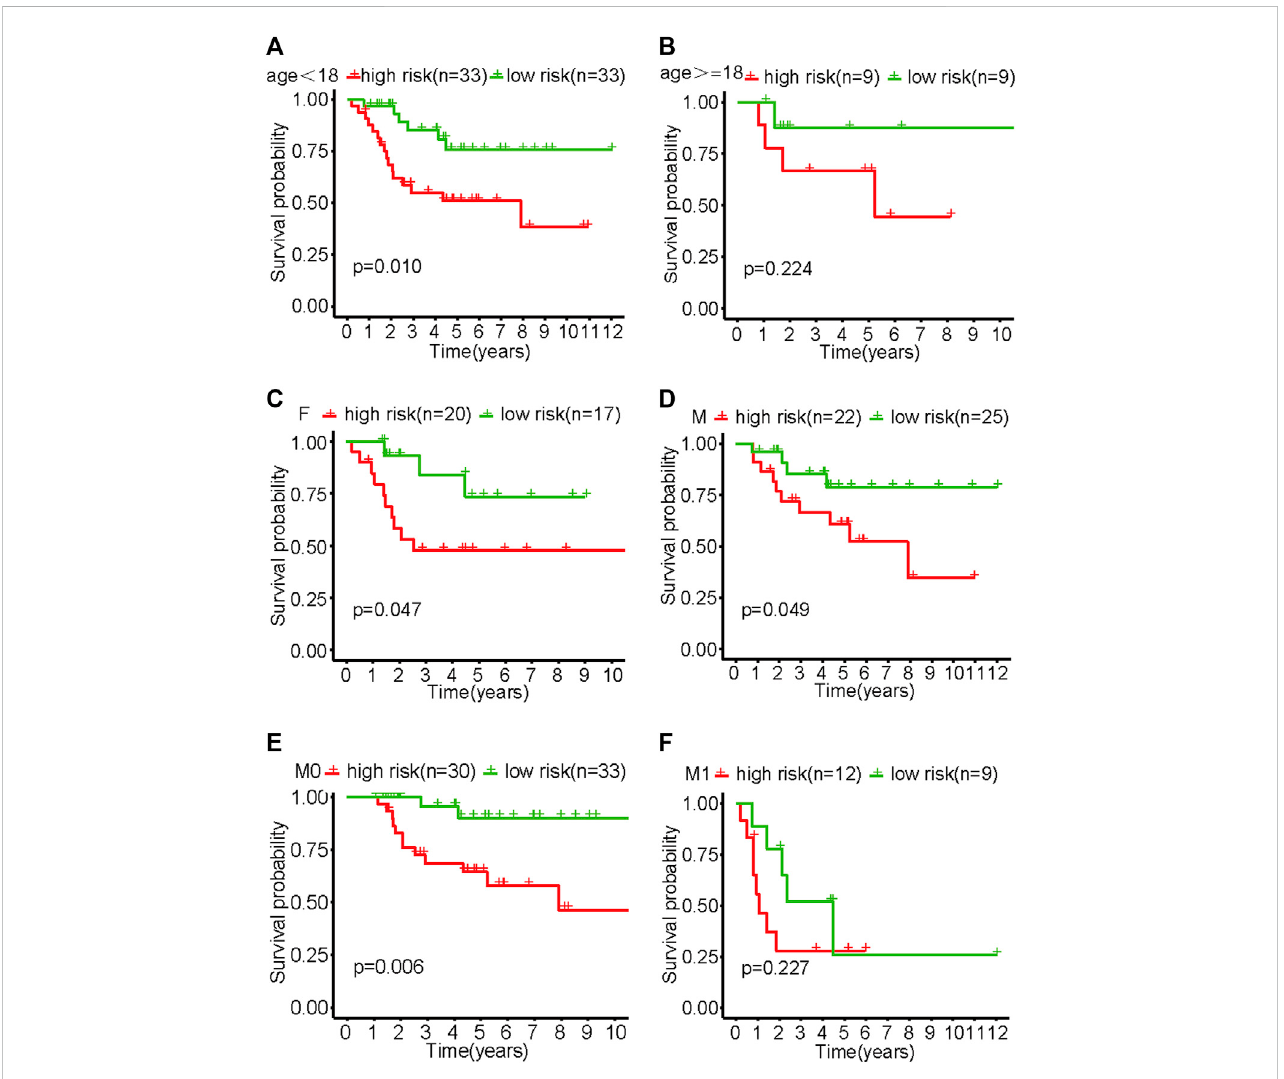
FIGURE 4 Survival curves of various subgroups in the high- and low-risk groups of patients with osteosarcoma. (A) Patients aged < 18. (B) Patients aged ≥ 18. (C) Females. (D) Males. (E) M0. (F) M1.